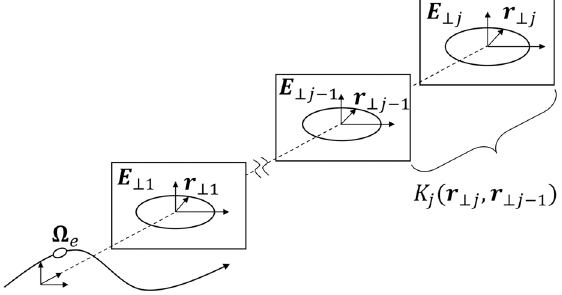
FIG. 2. A diagram introducing variables for the SR propagation in Eq.